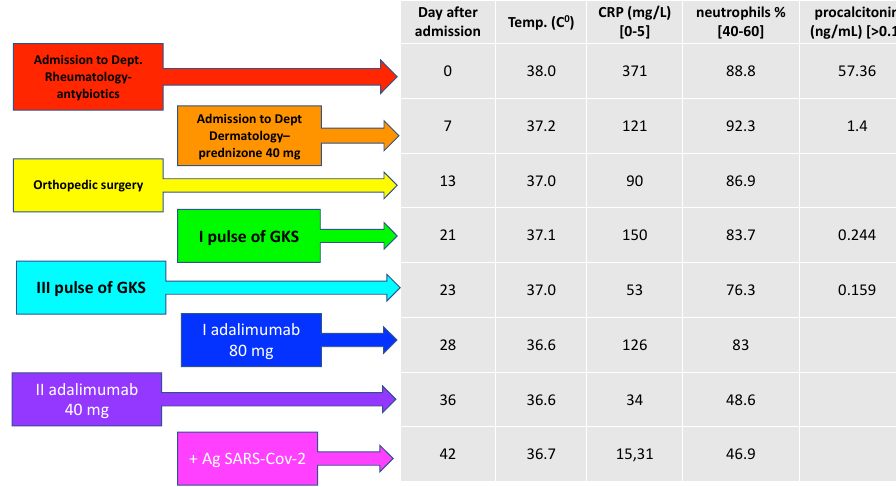
Figure 4. Laboratory findings and treatment in the course of hospitalization.